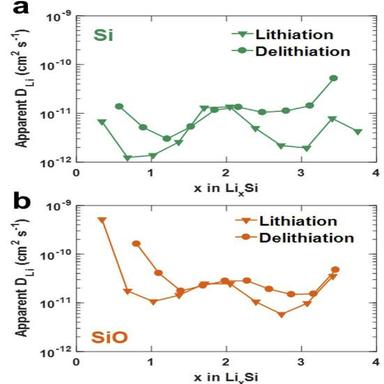
Variation in Li-diffusion coefficient of (a) Si and (b) SiO depending on Li-content (x) in LixSi measured by EIS at 25 °C.